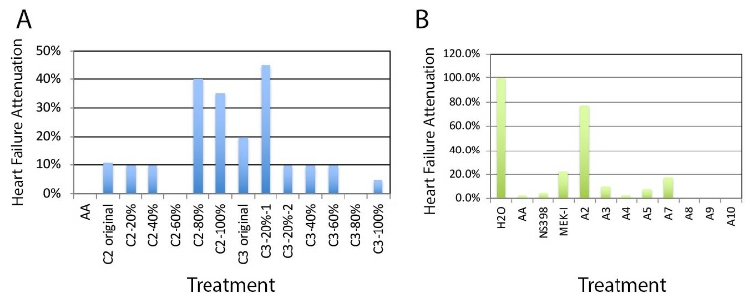
Figure 1. AHF attenuation by Trapa taiwanensis Nakai compounds. Two crude extracts from Chi- nese water chestnuts ( Trapa taiwanensis Nakai) were generated using different solvents, 50% etha- nol for C2 and water for C3. Initial tests using our zebrafish model showed AHF attenuation activ- ity. Both C2 and C3 extracts were proceeded with medium pressure column